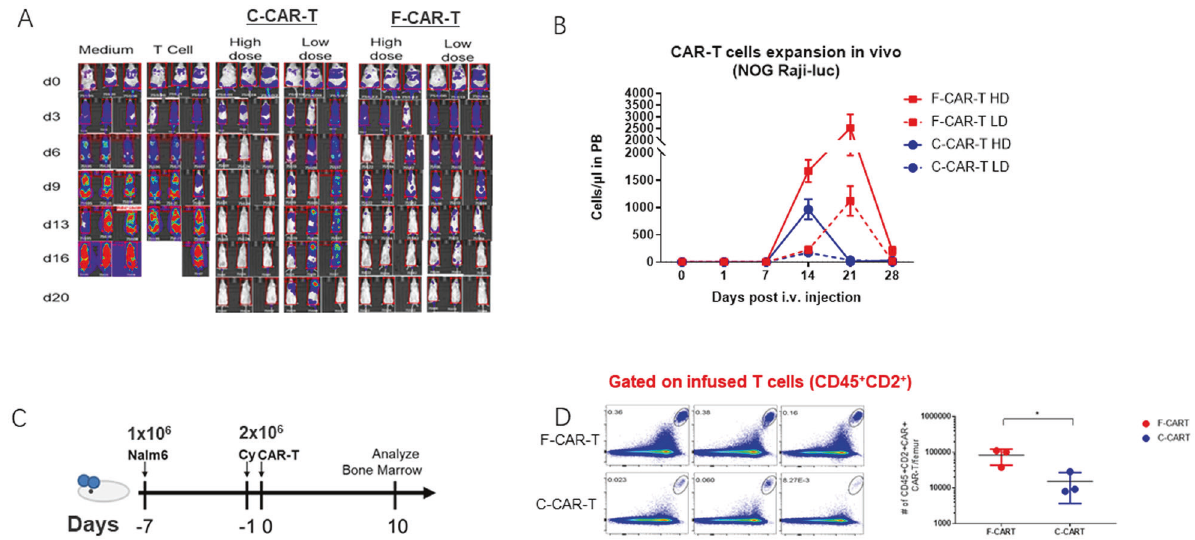
Fig. 2 F-CAR-T show superior killing capacity and bone marrow migration in vivo. A Raji-Luc cell engraftment NOG mice were given high dose (2 × 10 6 /mice, n = 3) and low dose (5 × 10 5 /mice, n = 3) F-CAR-T/C-CAR-T along with control groups. Tumor growth was monitored with IVIS scan once every 3 days; B CAR-T expansion in peripheral blood of mice was analyzed by fl ow cytometry ( n = 6). *** P < 0.001 for F-CAR-T HD vs. C-CAR-T HD; F-CAR-T LD vs. C-CAR-T LD; F-CAR-T HD vs. F-CAR-T LD; C-CAR-T HD vs. C-CAR-T LD (two-way ANOVA statistical analysis); C Schematic of the Nalm6 (1 × 10 6 ) xenograft model, CAR-T (2 × 10 6 ) infused 1 day after cyclophosphamide (20 mg/kg) treatment. Bone marrow in fi ltration of F-CAR-T was analyzed 10 days after CAR-T infusion ( n = 3); D CD45 + CD2 F-CAR-T vs. C-CAR-T in peripheral blood of mice were analyzed by fl ow cytometry; * P < 0.05 (unpaired student two-tailed t -test). IVIS in vivo imaging system, PB peripheral blood, i.v. intravenous, HD high dose, LD low dose, Cy cyclophosphamide; * p < 0.05; #: number.